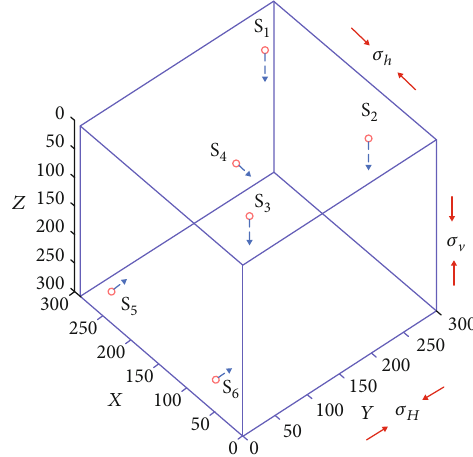
Figure 2: Independent con fi ning stresses applied and locations of sensors on the